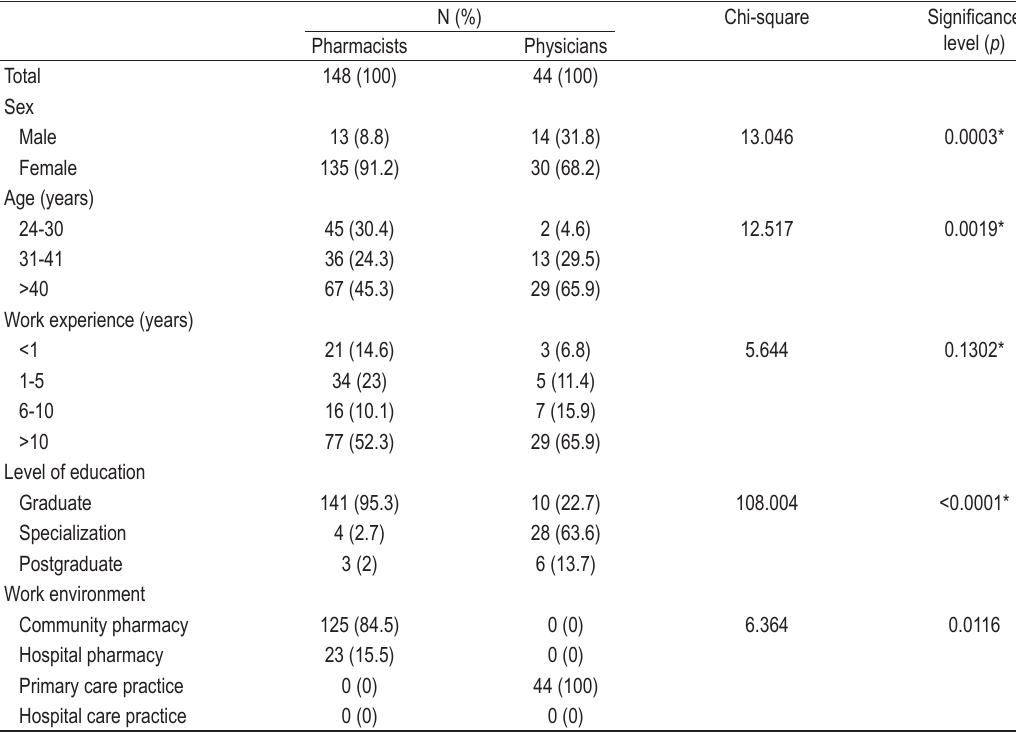
TABLE 1. Demographic and professional details of the